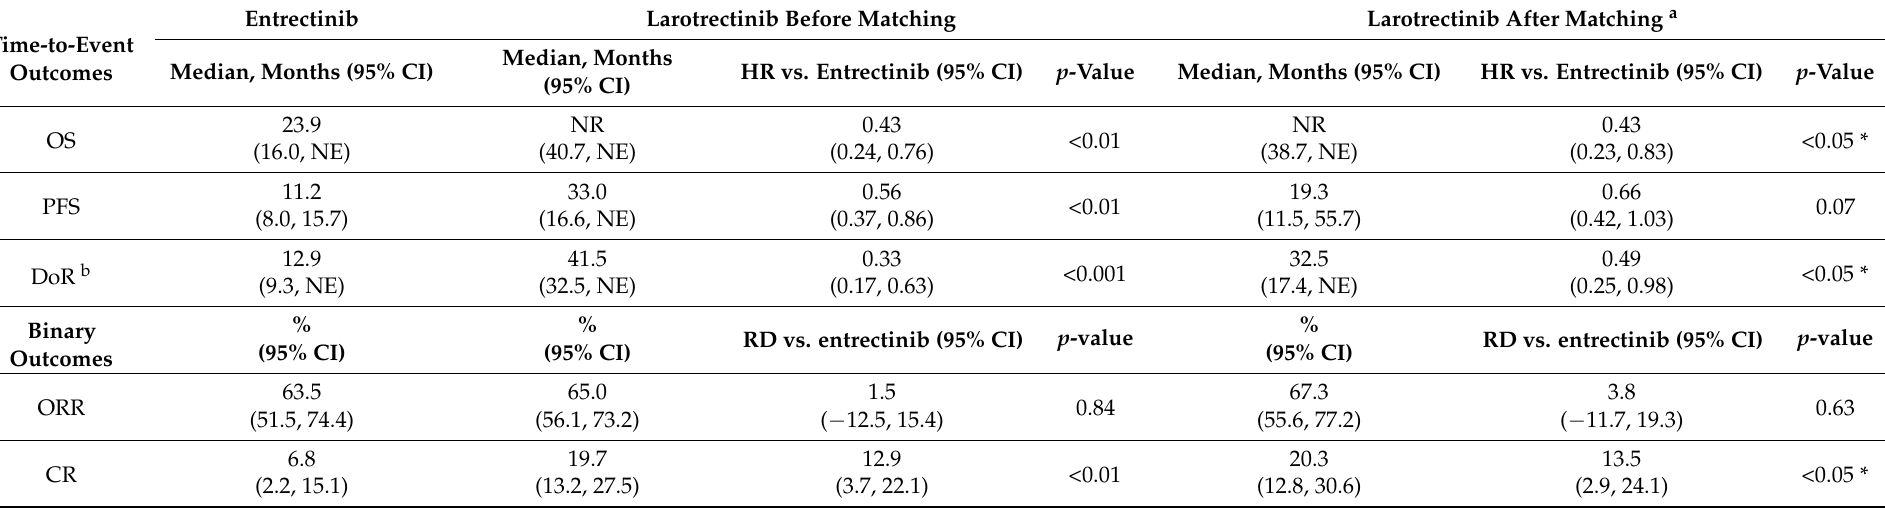
Table 3. Comparison of efficacy outcomes before and after matching (primary analysis).